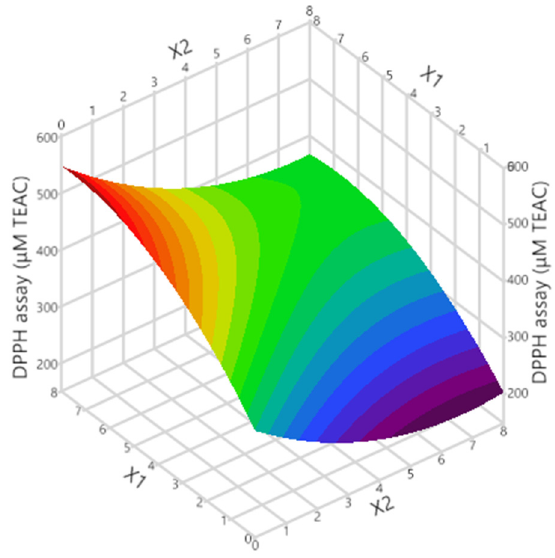
Figure 2. 3D graph showing the impact of the considered process variables on the response.